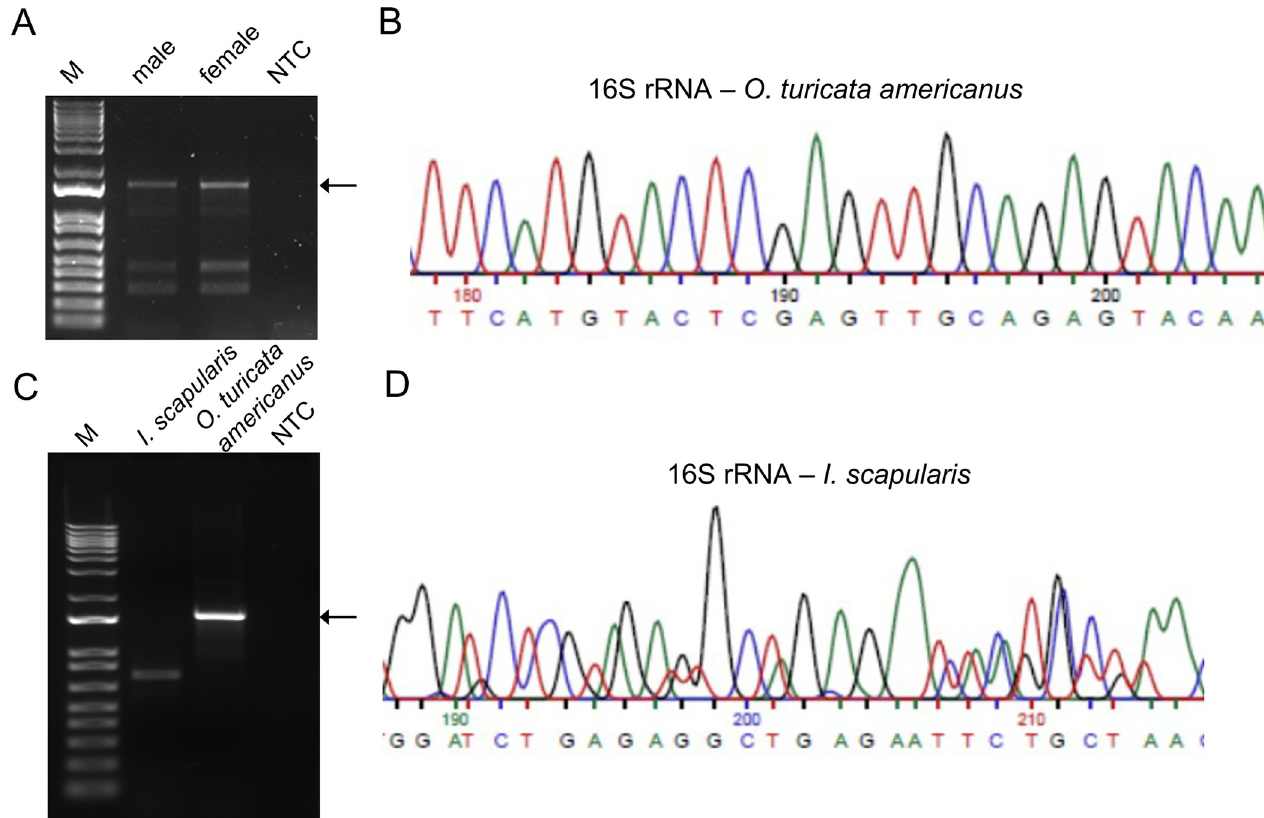
Fig 1. Identification of Occidentia -like species in O . turicata americanus ticks. Agarose gel image showing PCR amplification of 16S rRNA gene fragment from total DNA isolated from unfed O . turicata americanus adult male or female (A) and unfed O . turicata americanus adult female or unfed I . scapularis female tick (C). M indicates DNA marker. NTC indicates no-template control. Arrow in A and C indicates 16S rRNA product in O . turicata americanus ticks. Sequencing analysis of partial Occidentia -like species 16S rRNA sequence from unfed O . turicata americanus female (B) or I . scapularis female (D) tick is